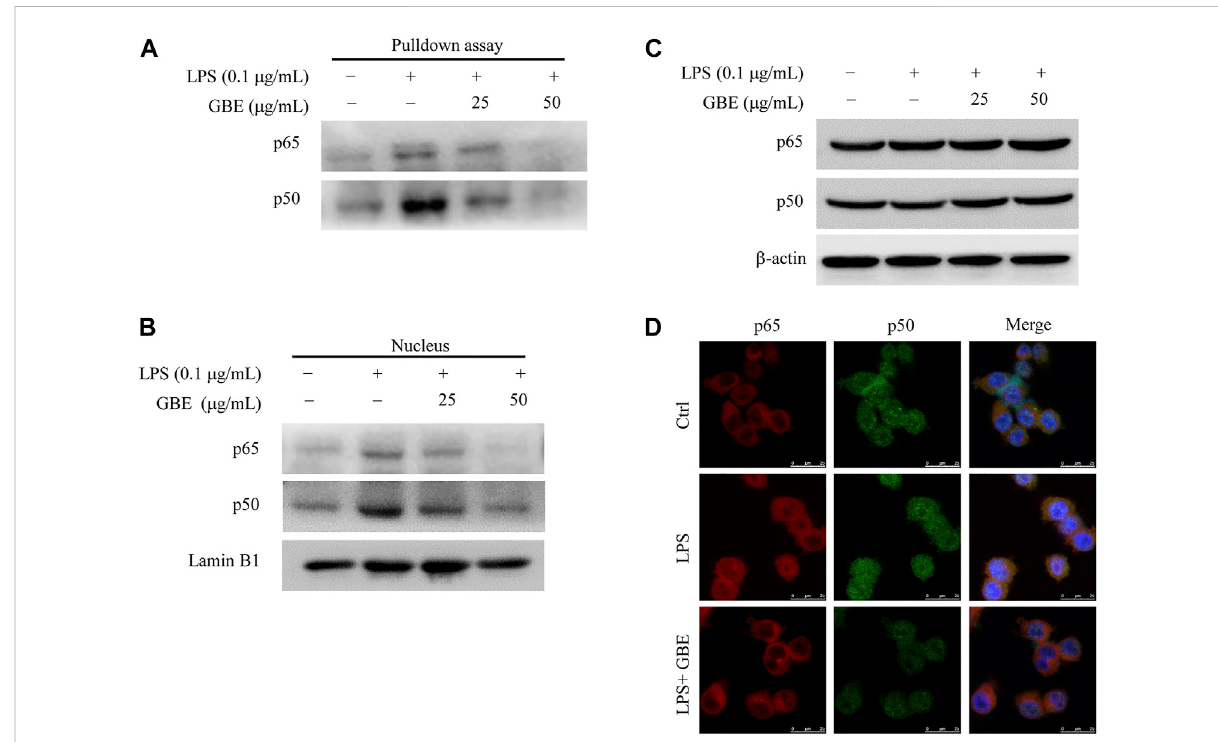
FIGURE 4 Effects of GBE on NF- κ B binding activity and translocation. BV-2 cells werepre-treated with GBE (25 and 50 µg/ml) for 1 h, and then incubated with or without LPS (0.1 µg/ml) for 24 h. (A) The binding of NF- κ B p65 and p50 to COX-2 promoter was analyzed using streptavidin-agarose pulldown assay. The protein levels of NF- κ B p65 and p50 in whole-cell lysates (B) and nucleus (C) were measured by western blotting analysis. β - actinandLaminB1wereusedascontrolsforsampleloading. (D) Thetranslocationofp50andp65fromcytoplasmtonucleuswereobservedin BV-2 cells with indicated treatment by immuno fl uorescence imaging analysis. Confocal microscopy analysis showed that LPS could effectively promote p50/p65 entry into the nucleus, while GBE treatment signi fi cantly reduced their entry into the